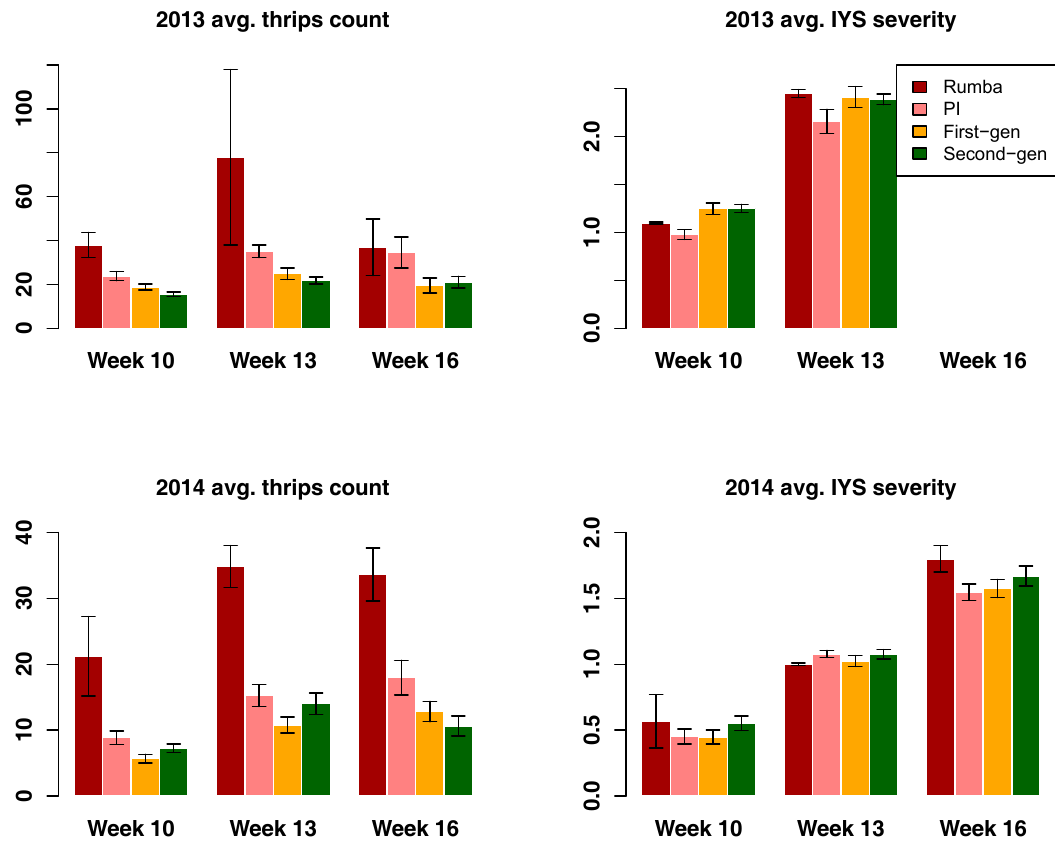
Figure 4. Barplots showing group-wise average ( top left ) thrip counts for each counting date for 2013, ( top right ) IYS severity for each rating date for 2013, ( bottom left ) thrip counts for each counting date for 2014, and ( bottom right ) IYS severity for each rating date for 2014. IYS severity rating was not performed for the third recording in 2013. Standard error is shown on top of each bar. Grouping legend is provided in the top right plot.